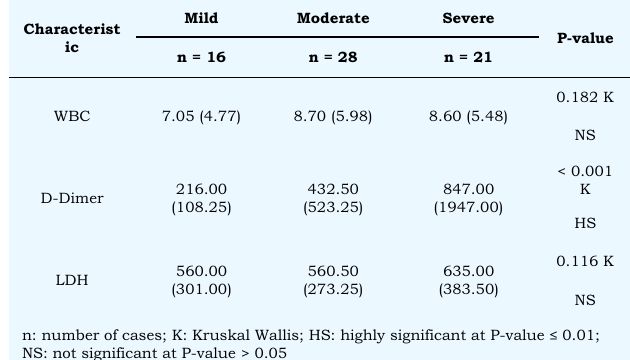
Table 4 Comparison of inflammatory markers according to the severity of disease